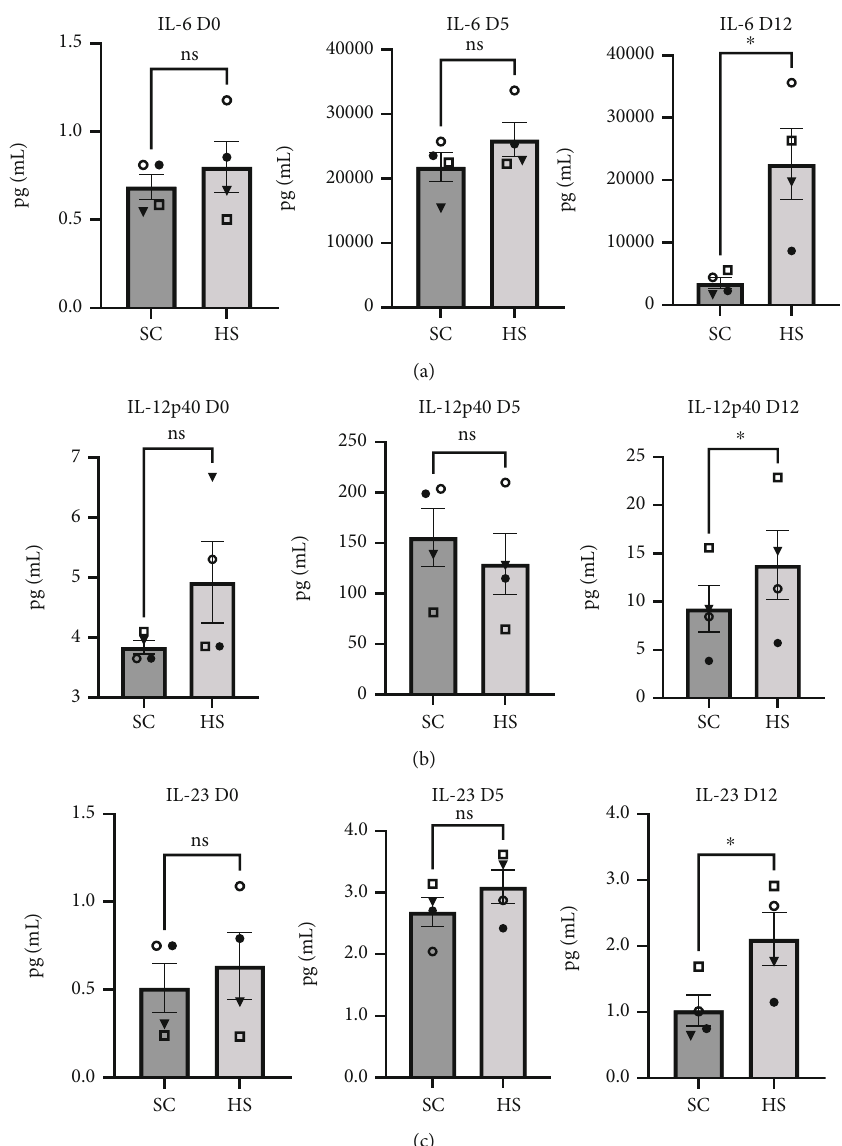
Figure 6: Immunomodulating cytokine concentrations in cell culture media with BMCs containing either sodium citrate (SC) or heparin sodium (HS) at day 0 (D0), day 5 (D5), and day 12 (D12): (a) IL-6, (b) IL-12p40, and (c) IL-23. Graphs display the population mean and standard error of the mean; shapes indicate donor-matched BMC products. ns: not signi fi cant, ∗ P < 0 : 05